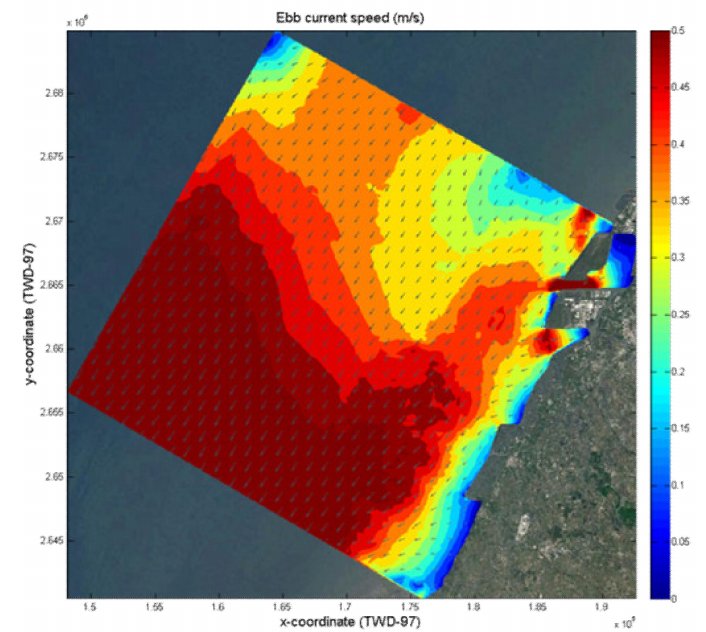
Figure 5. Current velocity and direction during ebb